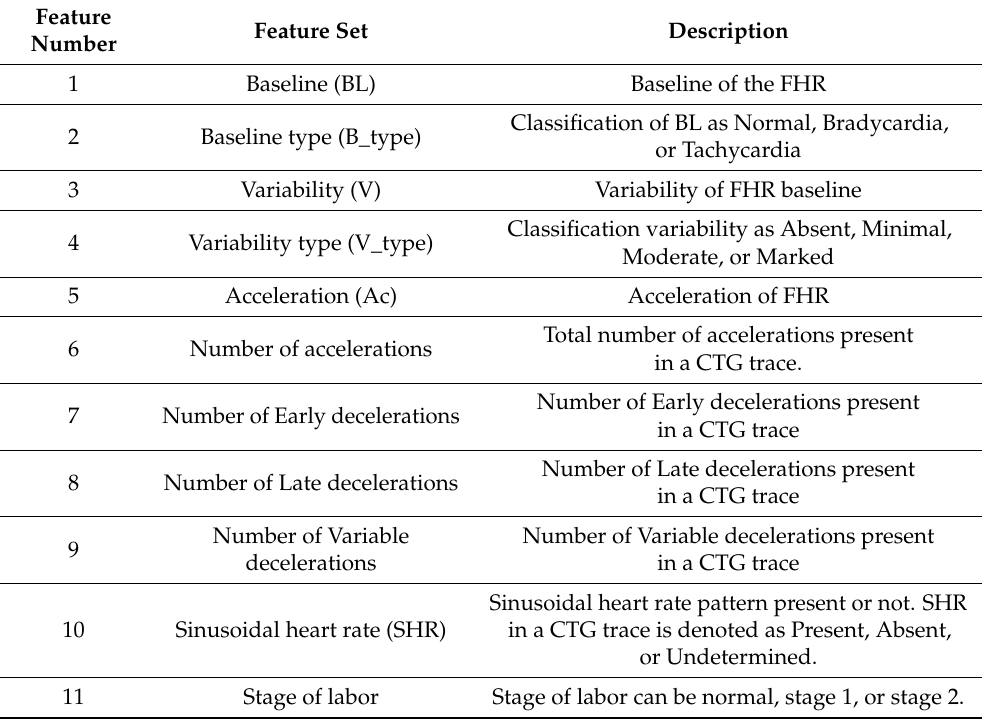
Table 1. Description of the feature set for the classification of